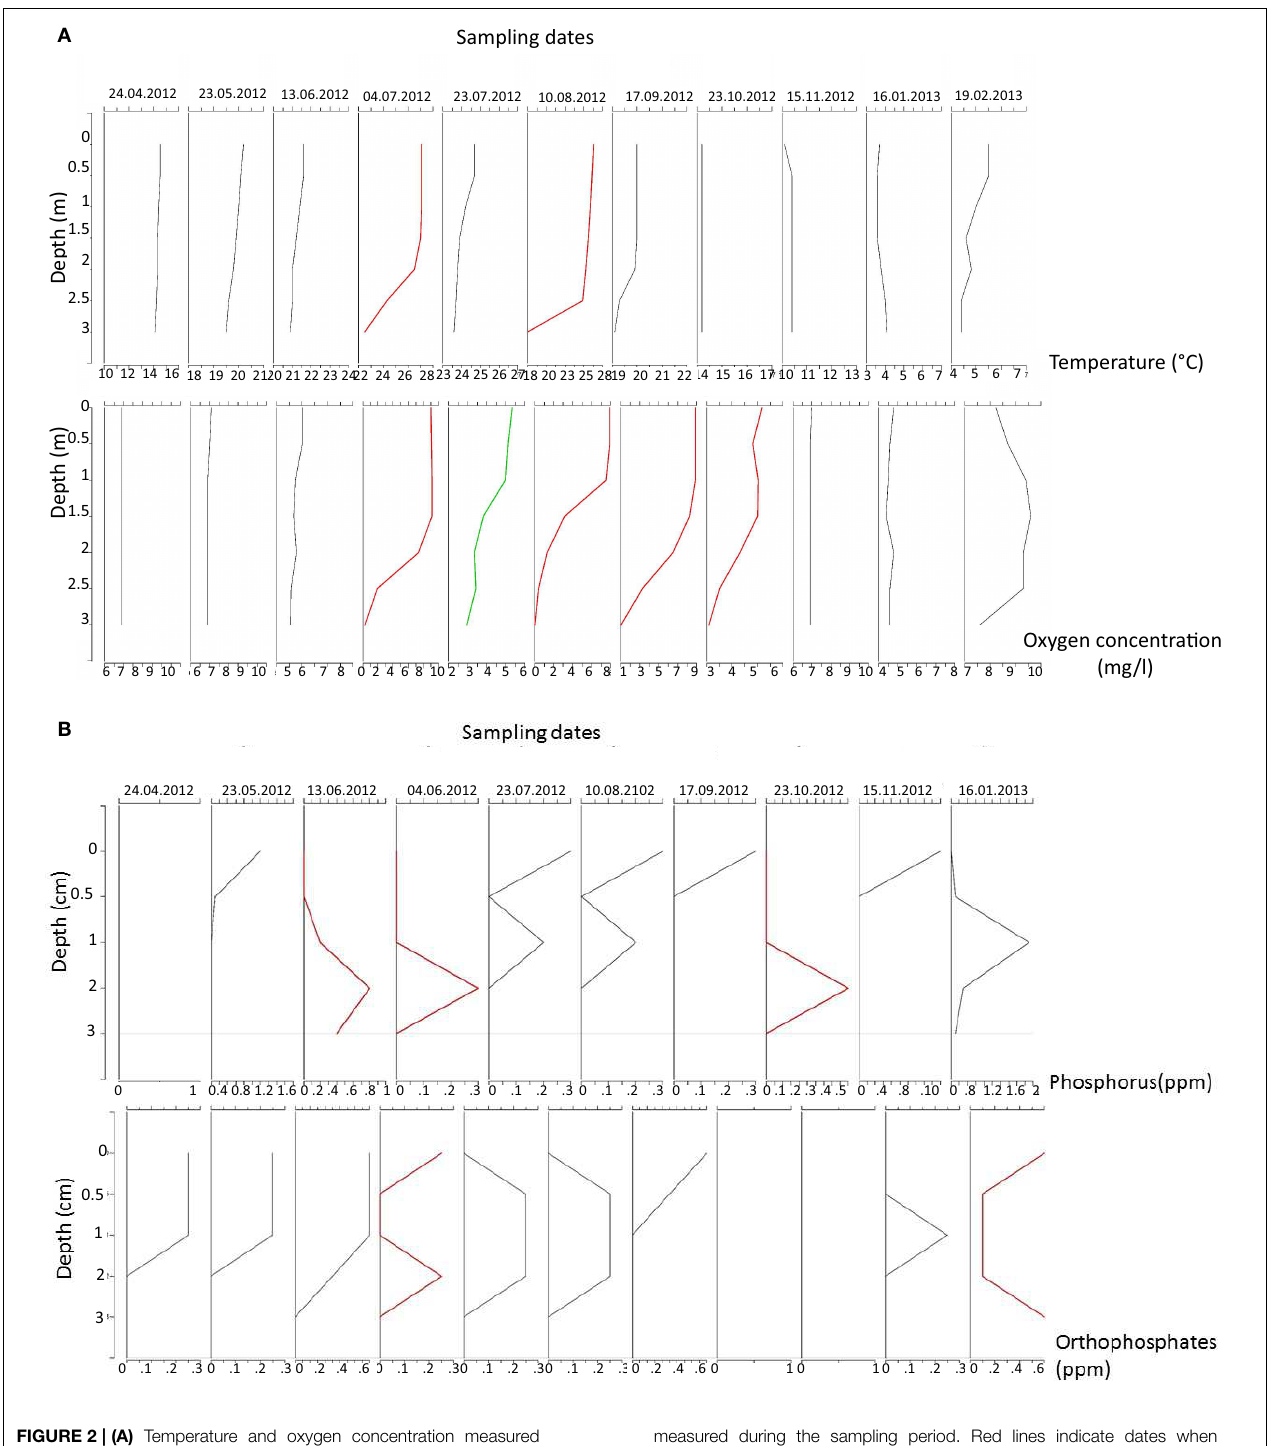
FIGURE 2 | (A) Temperature and oxygen concentration measured during the sampling period. Red lines indicate dates of established thermocline and anoxia. (B) Phosphorus and Orthophosphates